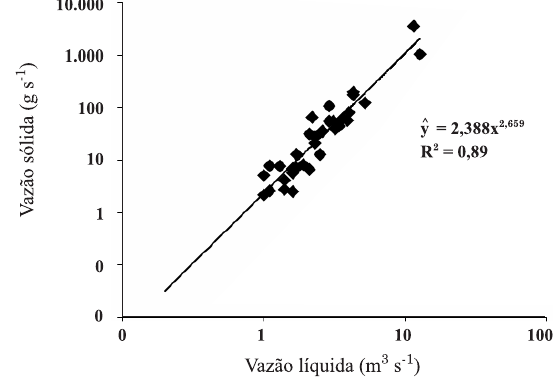
Figura 2. Correlação entre os dados observados de vazão líquida e sólida na bacia do ribeirão